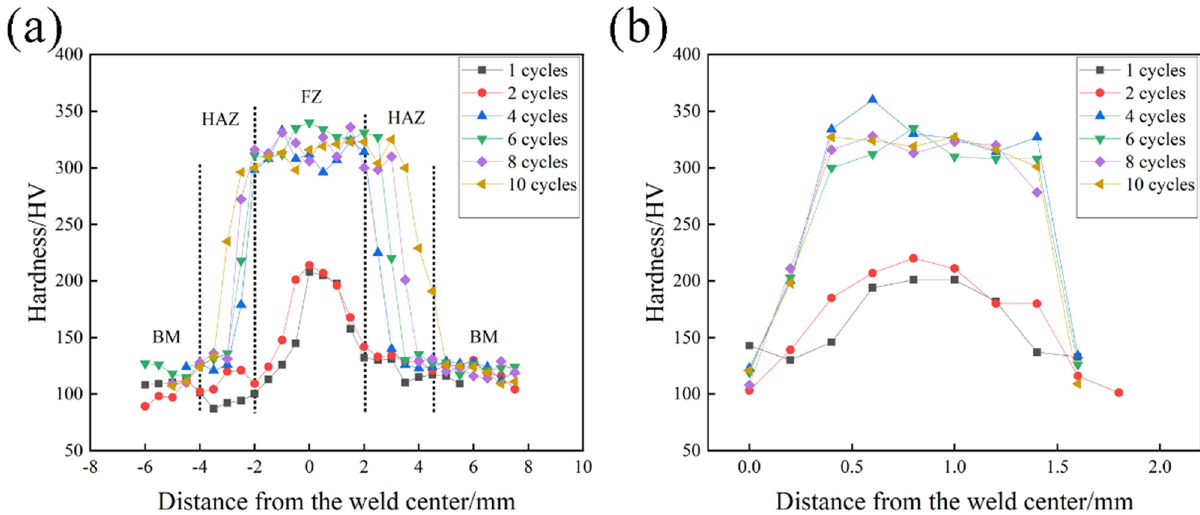
Figure 12: Microhardness in nugget formation: ( a ) horizontal direction, ( b ) perpendicular direction.